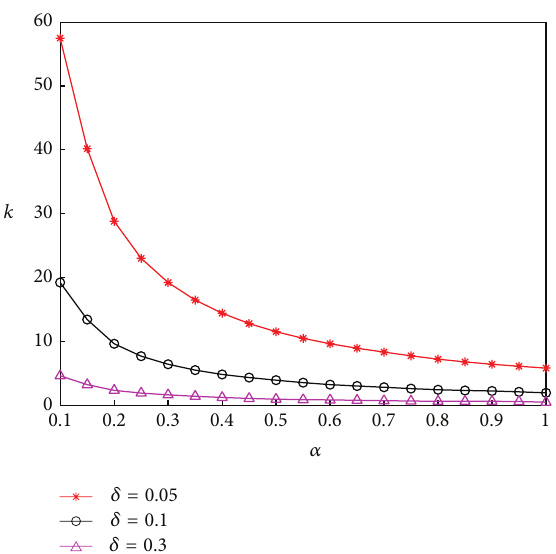
Figure 9: Correlation between 𝑘 and 𝛼 with given different 𝛿 .